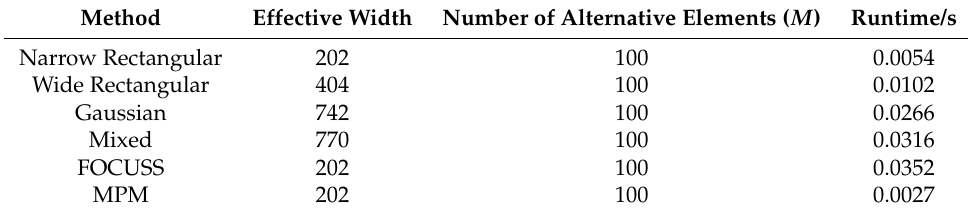
Table 1. The runtime of each method in Simulation 1.